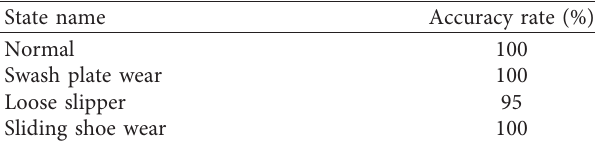
Table 4: The eigenvalue benchmarks of the four conditions of axial piston pump.